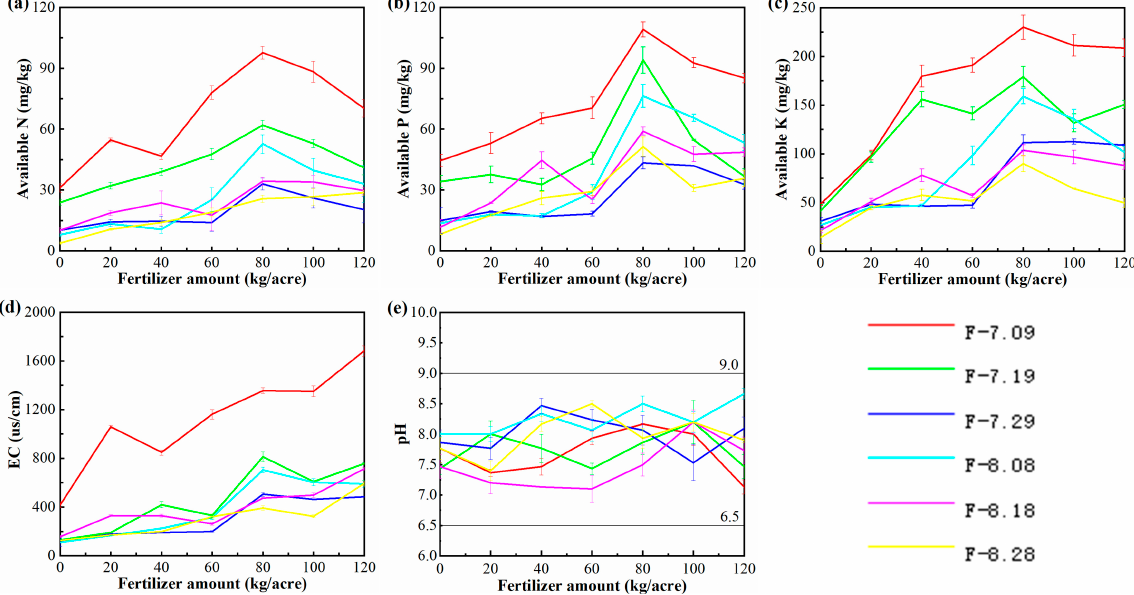
Figure 3. Relationship between soil fertility and fertilizer amount.